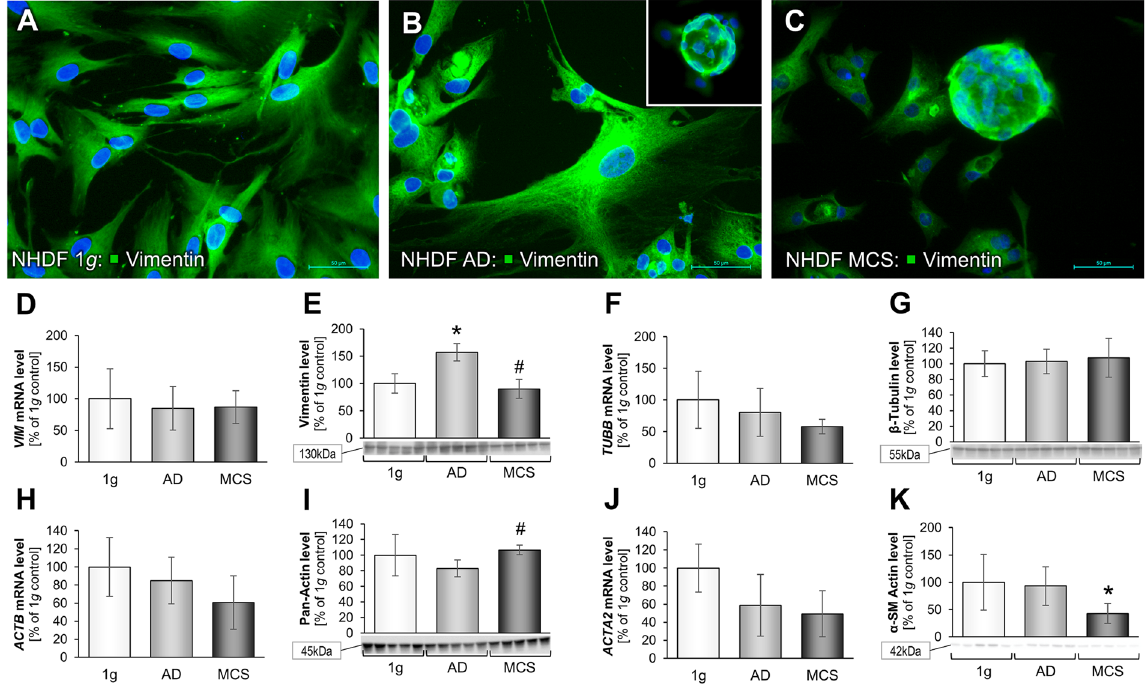
Figure 3. Cytoskeletal changes in NHDF cells after a 3-day s- µ g -exposure: Immunofluorescence images of 1 g -control cells, RPM-AD and RPM-MCS of vimentin ( A – C ). Transcriptional and translational vimentin analysis: Quantitative gene expression levels of VIM ( D ) and intracellular vimentin levels ( E ). Transcriptional and translational β -tubulin analysis: Quantitative gene expression levels of TUBB ( F ) and intracellular β -tubulin levels ( G ). Quantitative gene expression levels of ACTB ( H ). Intracellular pan-actin levels ( I ). Transcriptional and translational alpha smooth muscle actin analysis: Quantitative gene expression levels of ACTA2 ( J ) and intracellular alpha smooth muscle actin levels ( K ). Full-length blots of cropped Western blot images are presented in Supplementary Fig. S2. * p < 0.05 1 g vs. RPM; # p < 0.05 AD vs. MCS. Scale bars: 50 µ